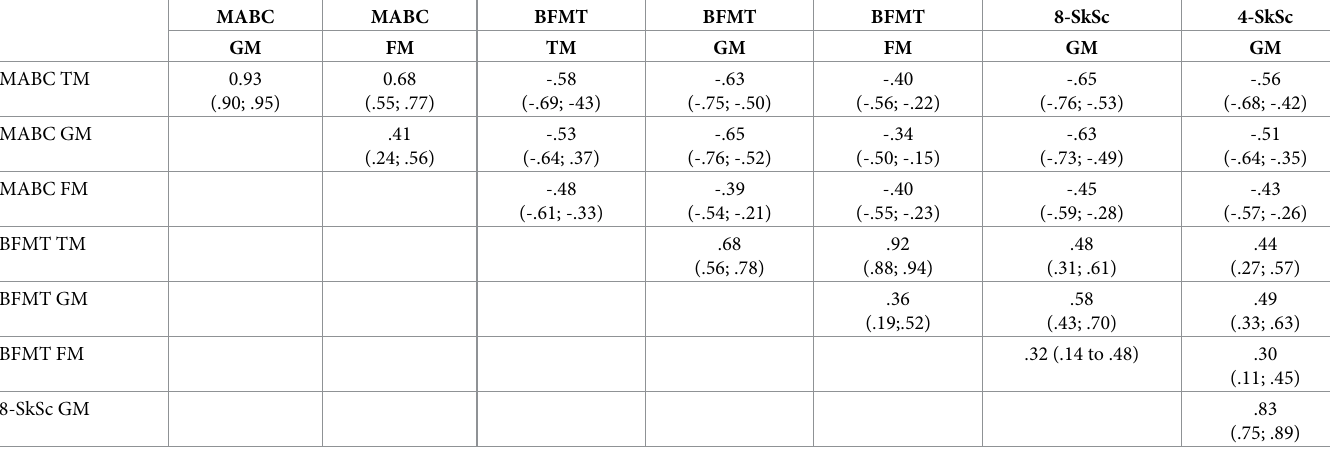
Table 3. Spearman’s correlation coefficients (with 95% CI) between the MABC, the BFMT and the 8- and 4-SkSc (N = 111).